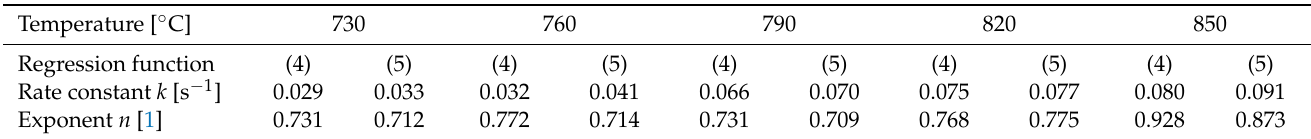
Table 1. Different values of the rate constant k and kinetic exponent n for different forms of the JMAK equation used as regression function: Equation (4) and linearised Equation (5).